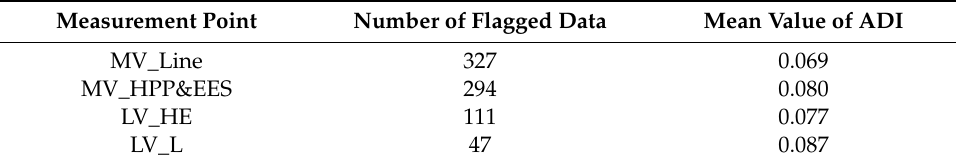
Table 3. Limit values of standard EN 50160 [121] used for the global